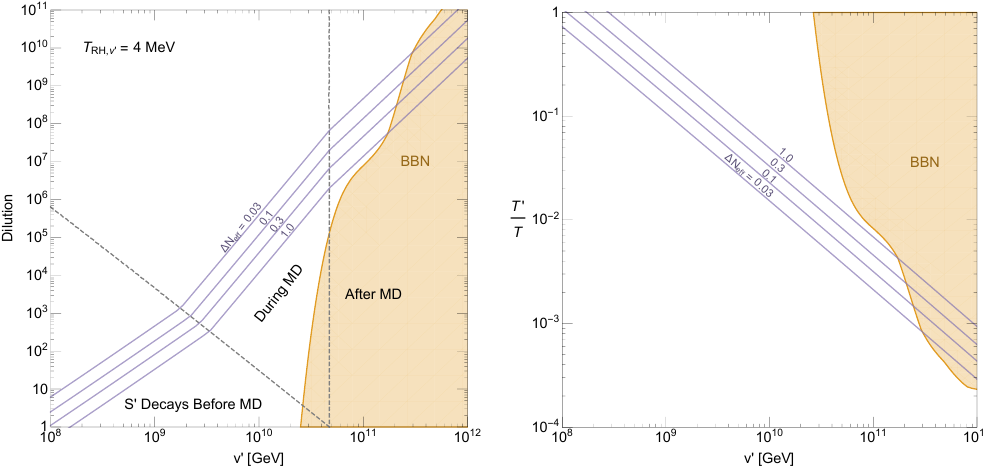
Figure 7 . (cid:1) N e(cid:11) contours (purple) and BBN constraints (orange) from S 0 ! (cid:13) 0 (cid:13) 0 ; HH y . In the left (right) panel the two sectors were (were not) initially thermally coupled so that DM is thermally produced via freeze-out and dilution (freeze-in). The temperature ratio of the two sectors, T 0 =T , is evaluated at the mirror con(cid:12)nement temperature. For clarity, we take A =